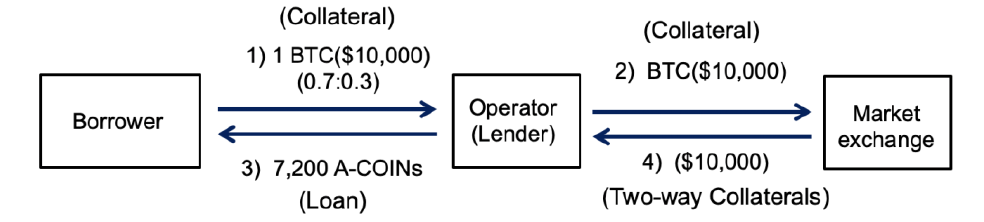
Fig. 2. An A-COIN loan process (the two-way collateral ratio is